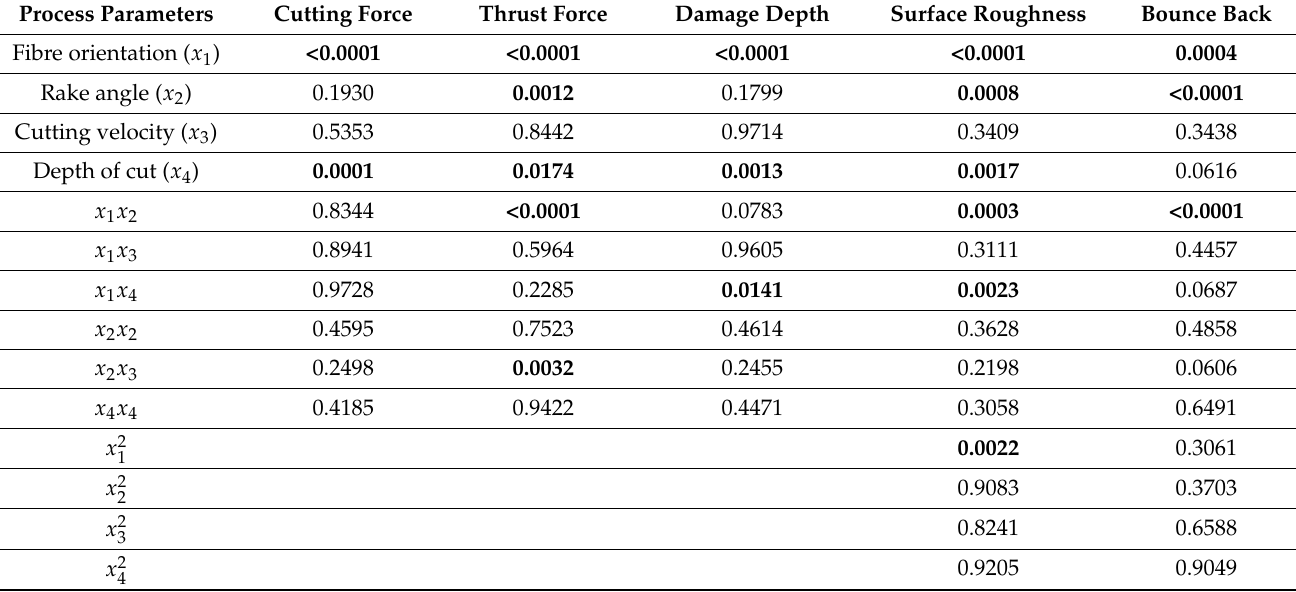
Table 5. Influence of process parameters and interactions on various response measures based on p -value. (bold numbers are those with less than